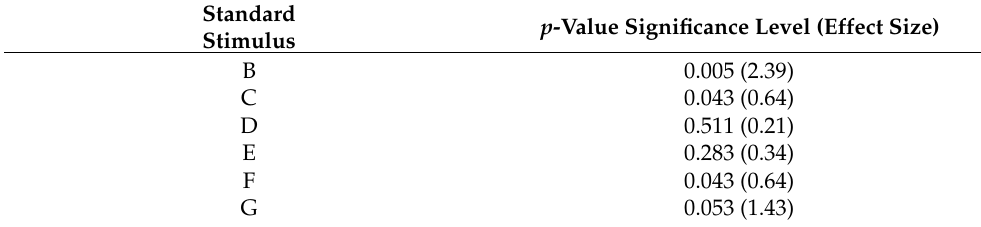
Table 3. t -test and Mann–Whitney U test with a significance level of 5% to confirm the differences between teachers’ and beginning learners’ correct answer